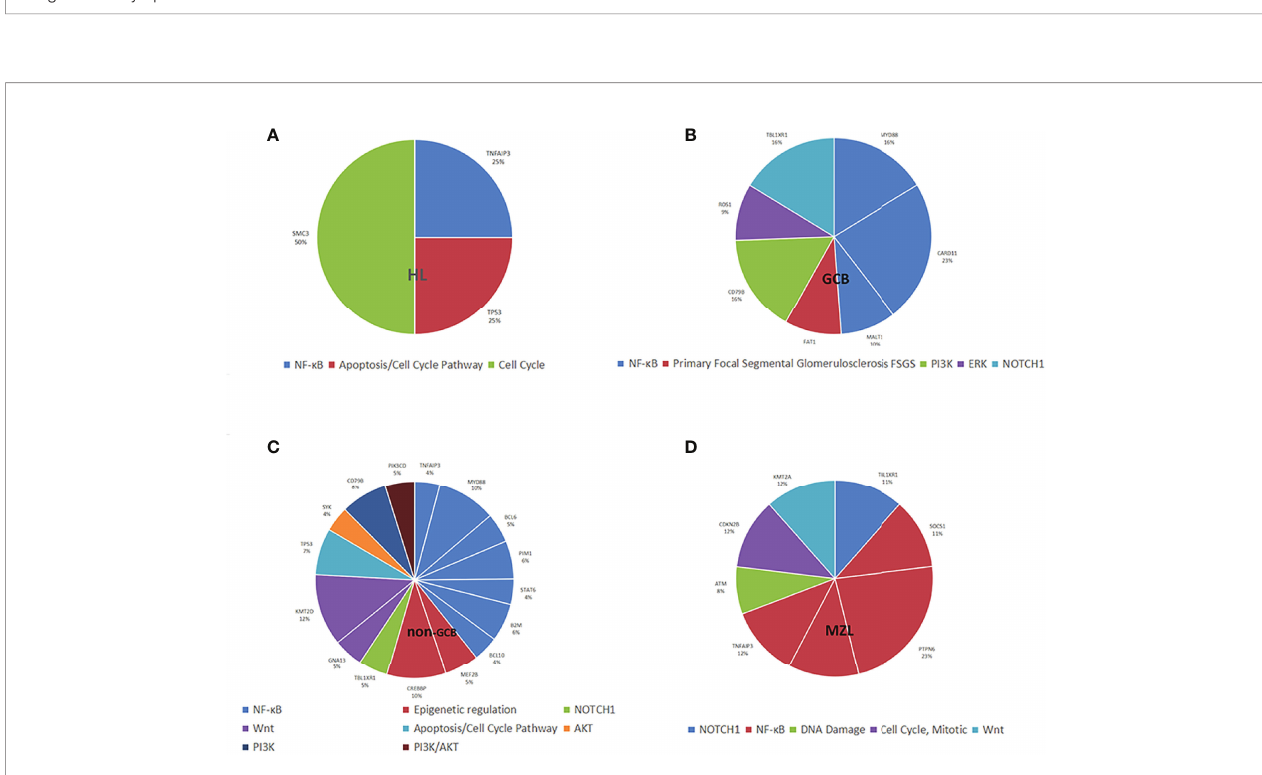
FIGURE 3 | Distribution of mutation allele frequencies and the pathways in lymphoma patients. (A) Mutation allele frequencies and the pathways in HL; (B) Mutation allele frequencies and the pathways in GCB; (C) Mutation allele frequencies and the pathways in non-GCB; (D) Mutation allele frequencies and the pathways in